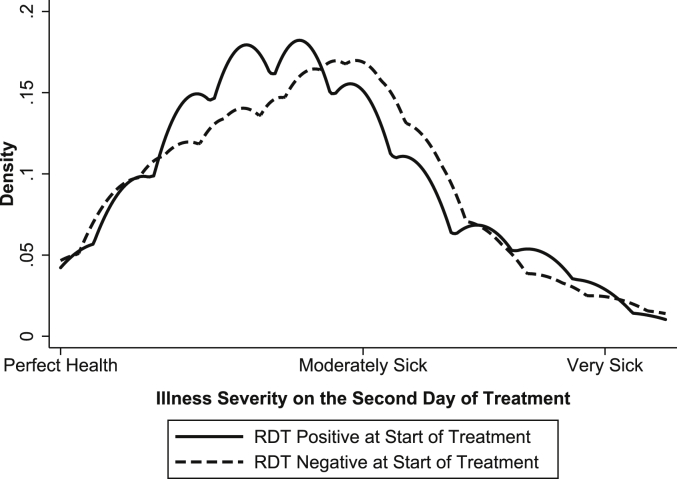
Distribution of Illness Severity on the Second Day of Treatment by Malaria Positivity at the Start of Treatment. The distribution of reported illness severities (using kernel density estimation) on the second day of treatment by whether they tested positive for malaria on the RDT at time of ACT purchase (solid line) or tested negative for malaria on the RDT (dashed line). Sample is limited to those who started taking the treatment.